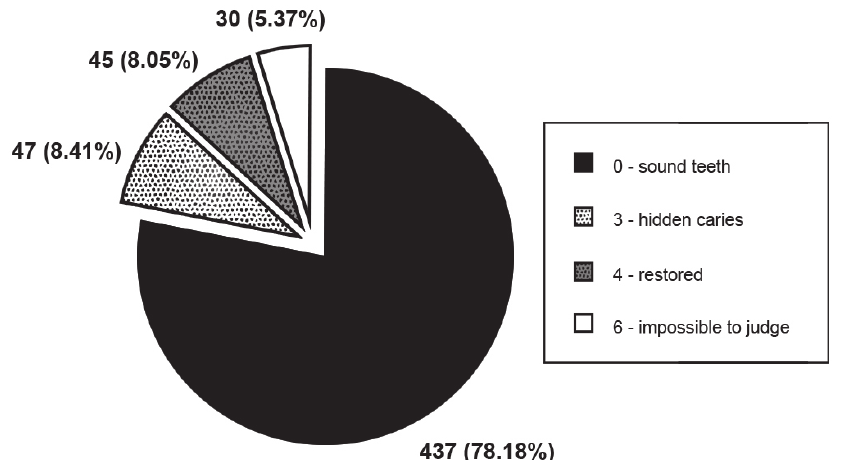
Figure 6- Distribution of Weerheijm, Gruythuysen and Van Amerongen 19 (1992) radiographic criteria on the evaluated